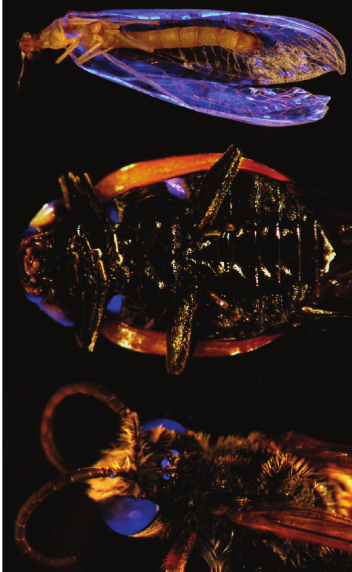
Figure 5: Blue fluorescence in UV light on Chrysoperla sp. (Neu- roptera: Chrysopidae) (top), Hippodamia convergens (Coleoptera: Coccinellidae) (middle), and Dieunomia nevadensis (Hymenoptera: Halictidae) (bottom). Color intensity digitally